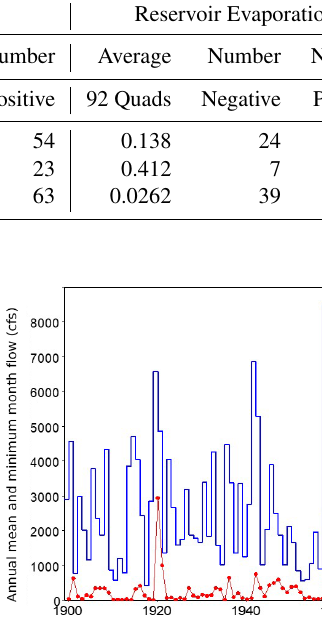
Figure 4. Daily Gauged Flows of Brazos River at Waco during 1 October 1898–4 July 2016. Figure 5. 1899–2015 Annual Mean Flow (blue solid line) and An-